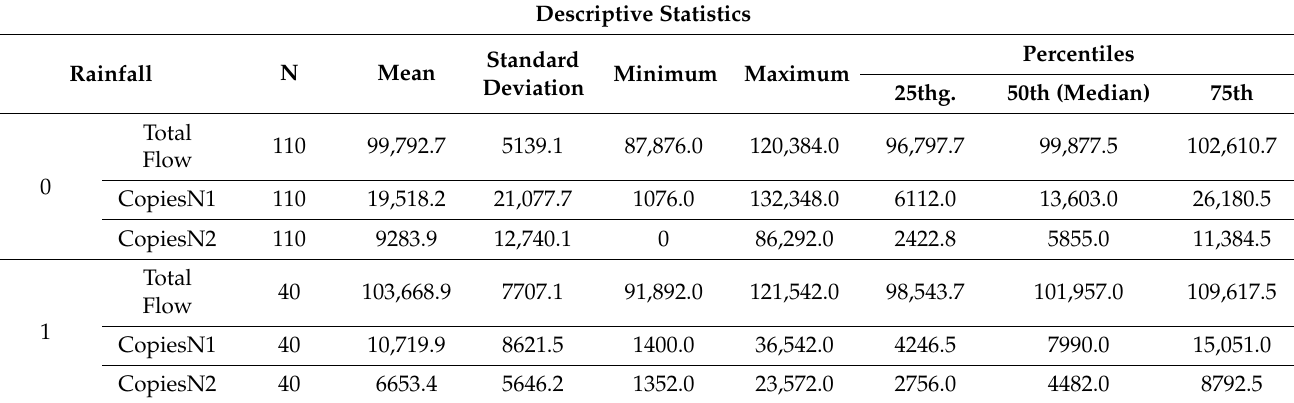
Table 3. Descriptive analysis of the parameters (Flow, N1 and N2 copies) related to periods with and without